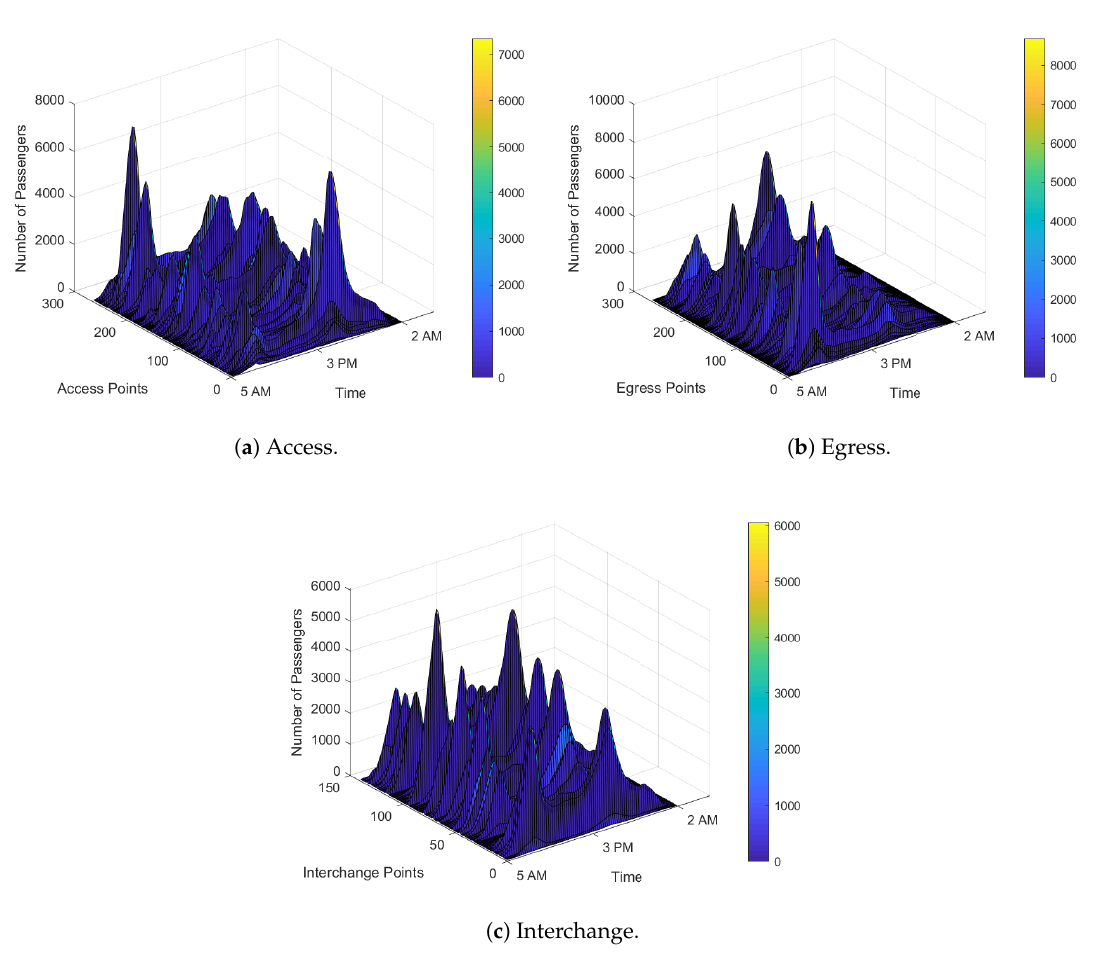
Figure 5. Simulation results for train traffic flows AEI framework considering three dimensional (3D) dataset for 1 week in the year 2017–2018. Plotted LUO dataset is from 05:00 AM to 02:00 AM (21-h) by different train lines on multiple stations with specific station numbers. Table 2. Classification of mobility prediction